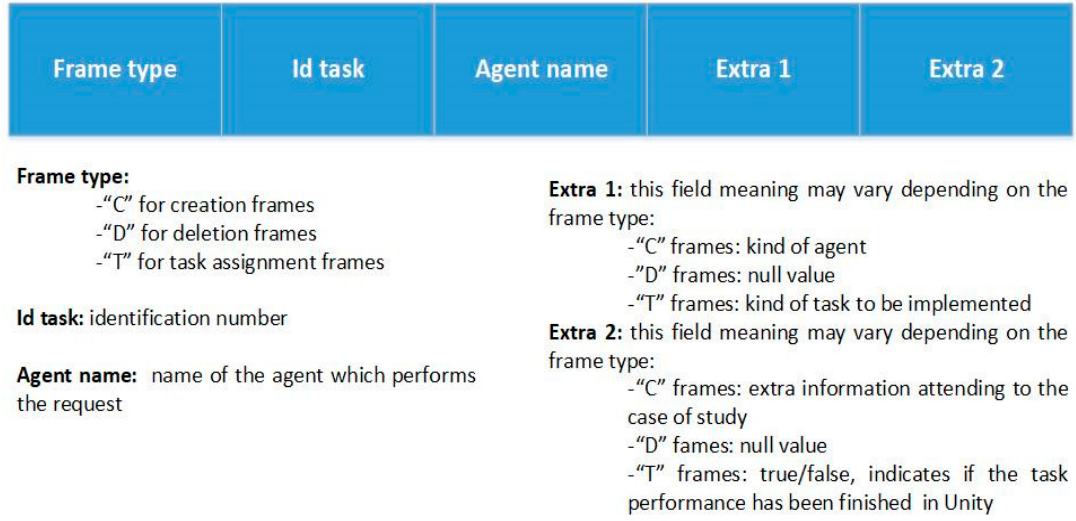
Figure 9. Communication frame.